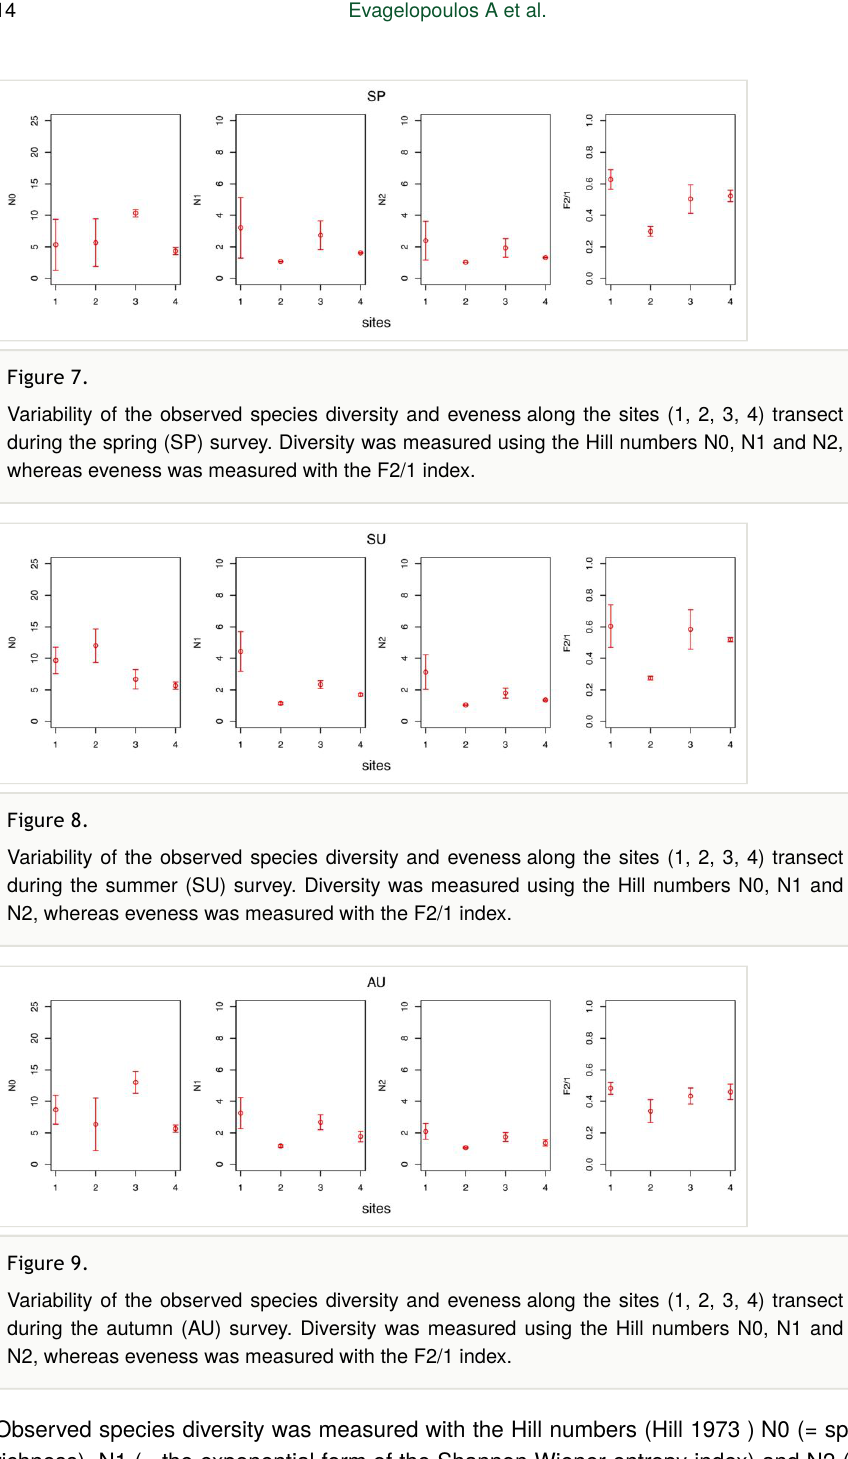
Observed species diversity was measured with the Hill numbers (Hill 1973 ) N0 (= species richness), N1 (= the exponential form of the Shannon-Wiener entropy index) and N2 (= the